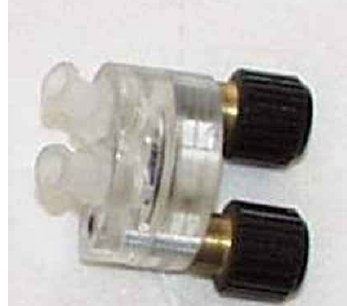
Figure 4. Plexiglas chamber utilized during the flow analysis of protein-protein interaction: the upper part, with the flow inlet and outlet, allowed the easy insertion of the biological fluid to be analysed and the lower allowed the proper housing of the